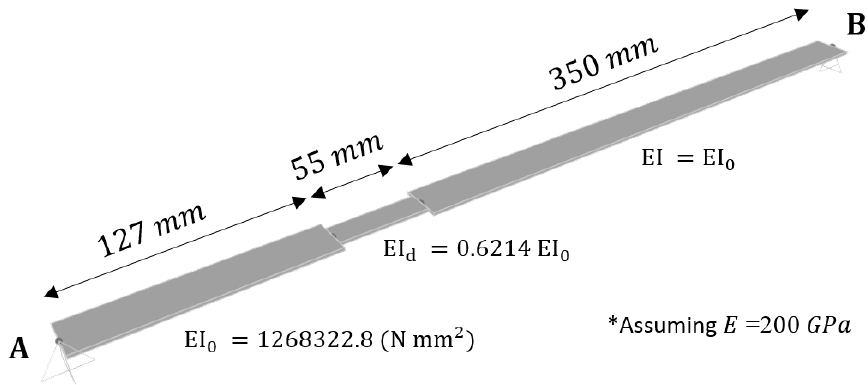
Figure 8. Geometry configuration and material of the numerical model.